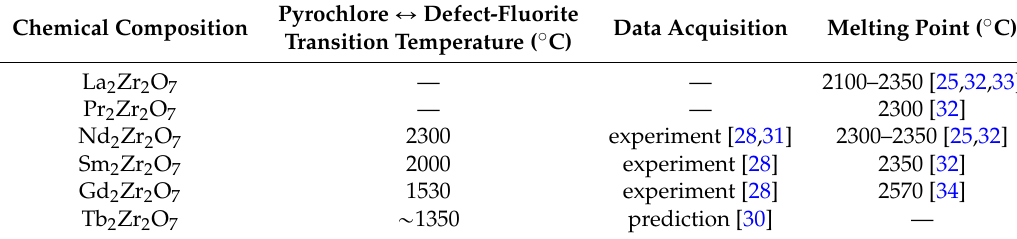
Table 2. Summary of the reported structural phase transition temperatures and melting points of some A 2 Zr 2 O 7 oxides. The order to disorder transformation temperatures were either obtained experimentally [28,31] or predicted by calculations [30]. A large number of phase diagrams can be found in the literature for the ZrO 2 - A 2 O 3 systems and the published results vary considerably, however the melting temperatures in all cases are reported to be higher than 2000 ˝ C for the A 2 Zr 2 O 7 oxides. The melting points were obtained from measurements [25,32,33] and/or estimated from calculations of the phase diagrams